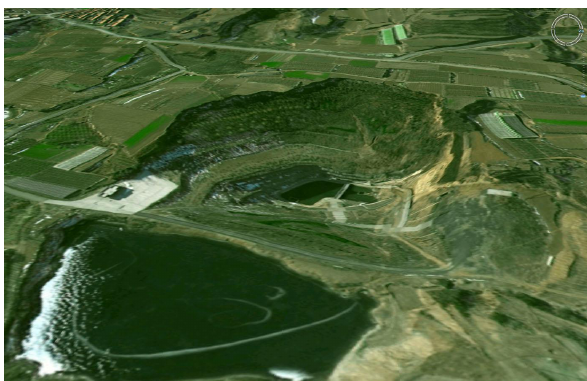
Figure 16. crater basin Shanwang geopark